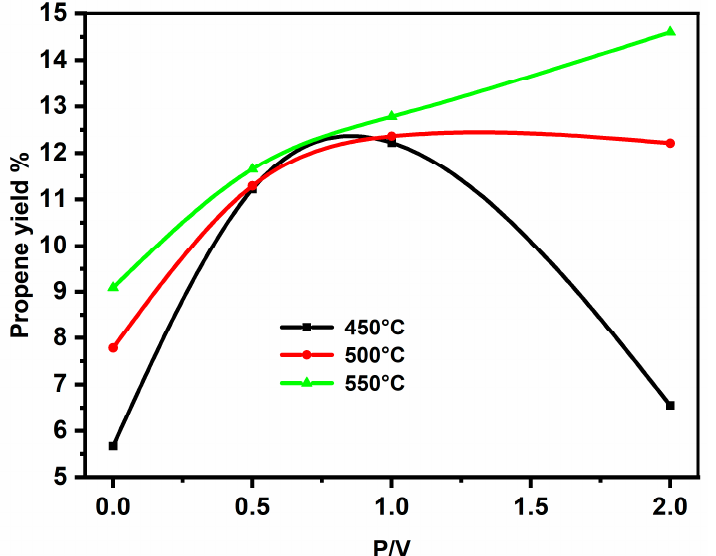
Figure 14. Propane yield depending on the reaction temperature and P/V ration in 3.6 wt% V 2 O 5 /ZrO 2.